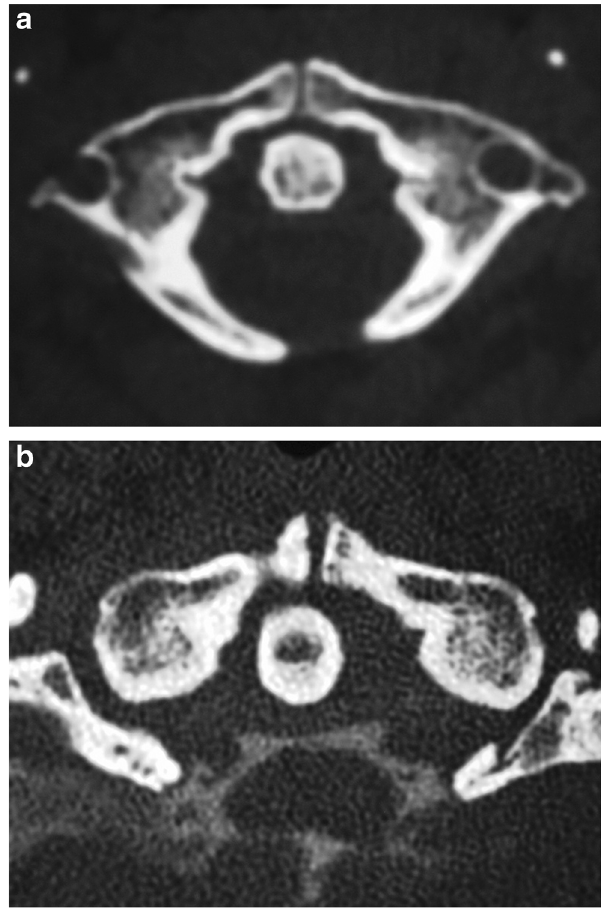
Fig. 15 Persistent ossiculum terminale: Sagittal ( a ) and axial ( b ) images from a non-contrast CTof the cervical spine in a 32 year old demonstrate a small, well-corticated ossific density along the superior margin of the dens ( arrows on images a and b ). This likely represents the persistent ossiculum terminale, which arises as a result of failure of fusion of the secondary ossification centre with the superior aspect of the dens. This entity can be mistaken for a remote type I fracture of the dens